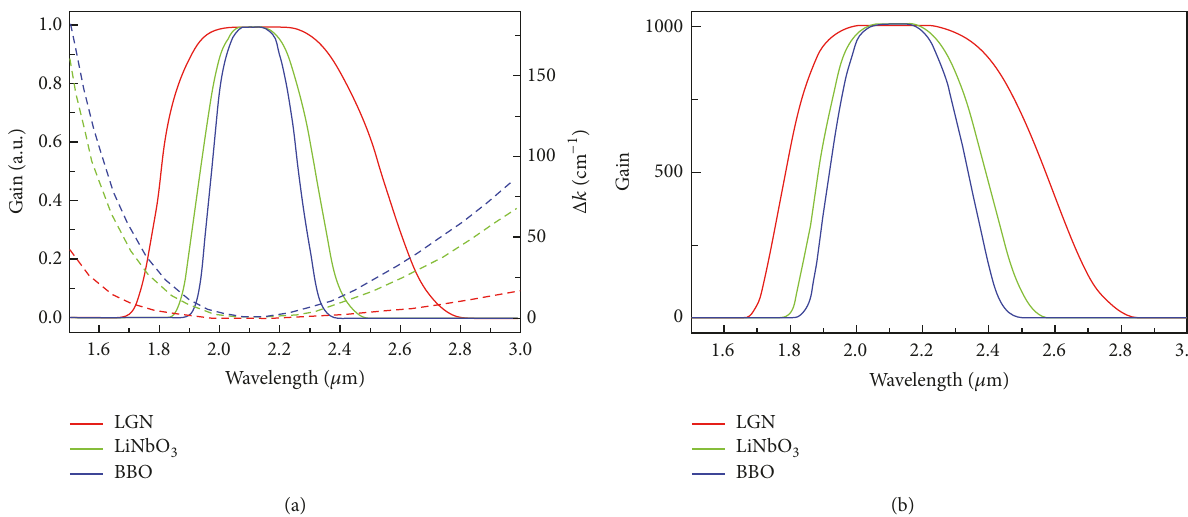
Figure 9: (a) Gain spectra (solid curves) and phase mismatches (dashed curves) for a 2.108 𝜇 m degenerate OPA pumped at 1.054 𝜇 m. Red, green, and blue curves correspond to LGN and LiNbO3 crystals. (b) Comparisons under the same gain for different crystals. Reprinted with permission from [21]. Copyright 2016 Optical Society of